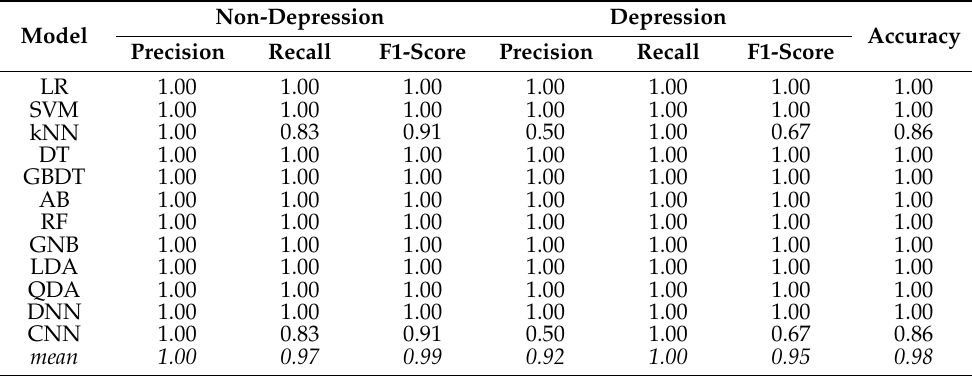
Table 4. After extending the 12 ML models by applying all of the proposed optimizations (multimodal analysis, feature selection, data augmentation, and two-stage detection), HADD showed an average accuracy of 0.98. Non-Depression Depression Model Recall